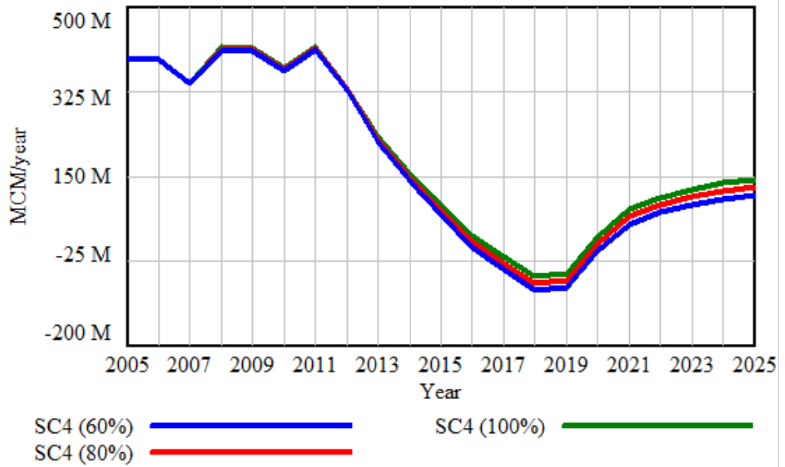
Figure 13. Impact of wastewater reuse on water